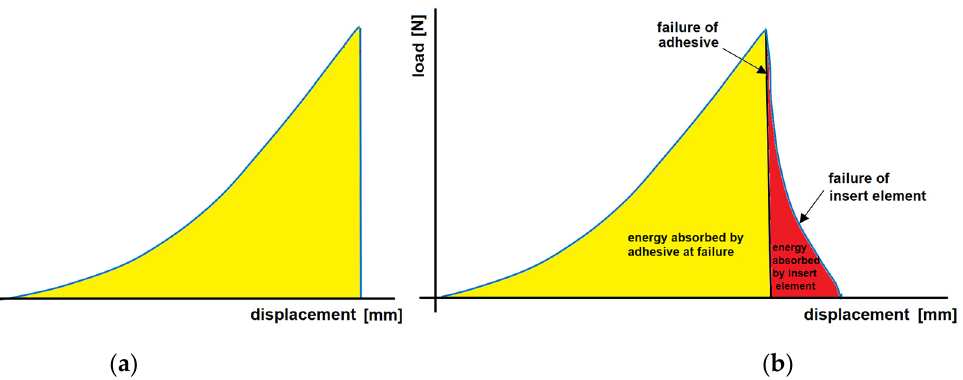
Figure 14. Load–displacement curve for ( a ) pure adhesive-bonded joint and ( b ) hybrid welded joint combined with adhesive bonding.